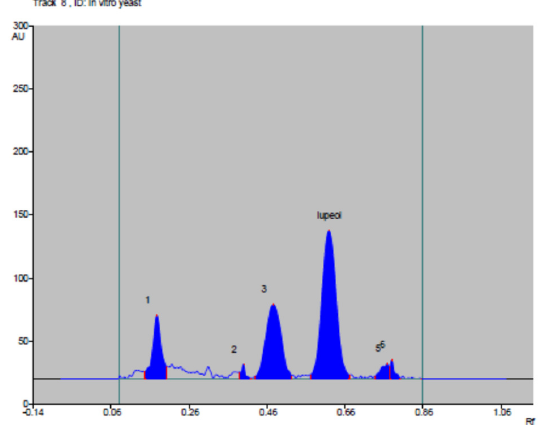
Figure 4c. HPTLC chromatogram of in vitro yeast extract-treated plant